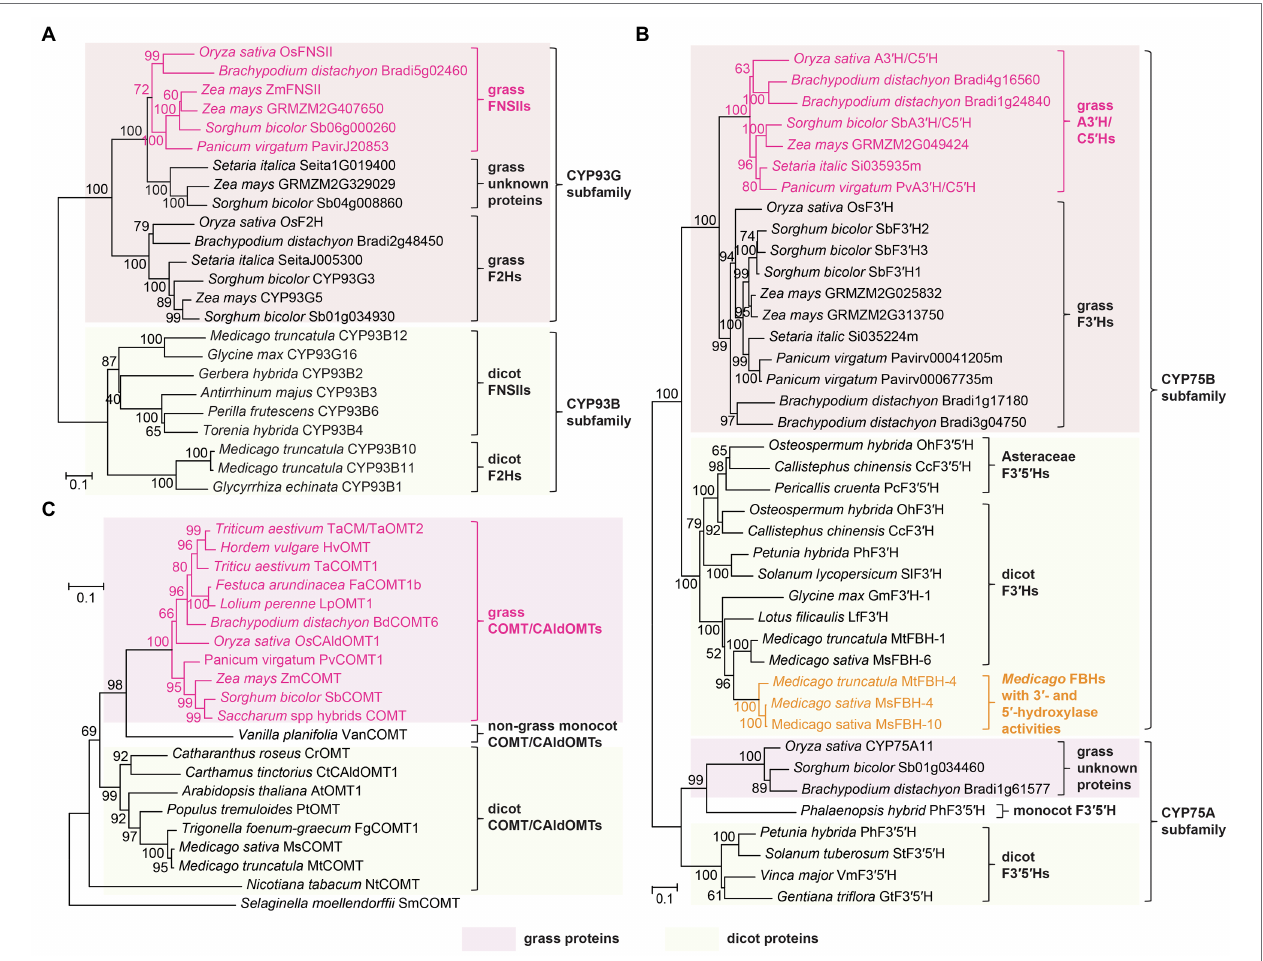
FIGURE 6 | Phylogeny of tricin biosynthetic enzymes. Phylogenetic trees of (A) FNSIIs and F2Hs; (B) A3 ' H/C5 ' Hs, F3 ' Hs, and F3 ' 5 ' Hs; and (C) COMT/CAldOMTs in grasses and dicots, constructed based on previously published studies (Lam et al., 2017, 2019b; Lui et al., 2020). The unrooted phylogenetic trees were built by neighbor-joining method using MEGAX (Kumar et al., 2018). Bootstrapping with 1,000 replicates was performed. Scale bar denotes 0.1 substitutions per